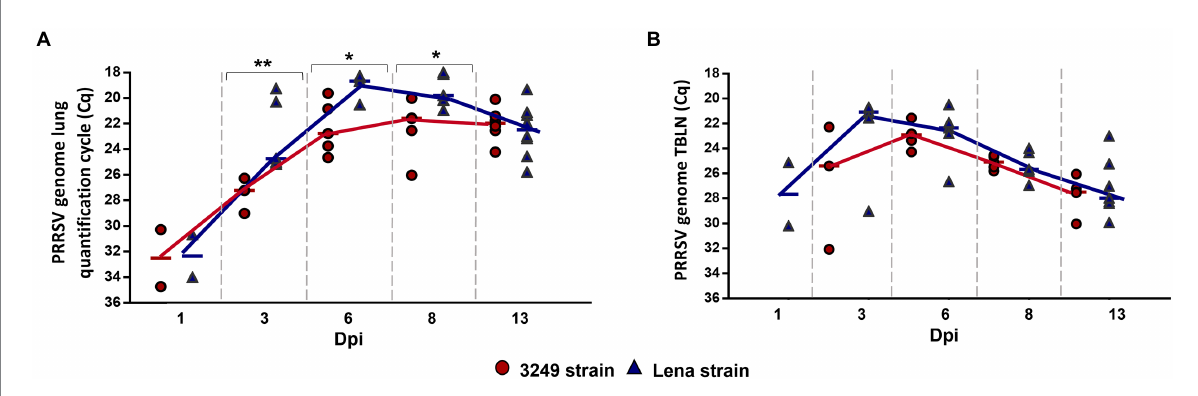
FIGURE 2 Graphs represent PRRSV viral load in lung (A) and tracheobronchial lymph node (TBLN) (B) from 3249- (red circles) and virulent Lena- (blue triangles) infected groups. PRRSV viral load is represented in quantification cycle (Cq). Significant differences between groups in lung are represented (* p ≤ 0.05 and ** p ≤ 0.01). Dpi, days post-infection.